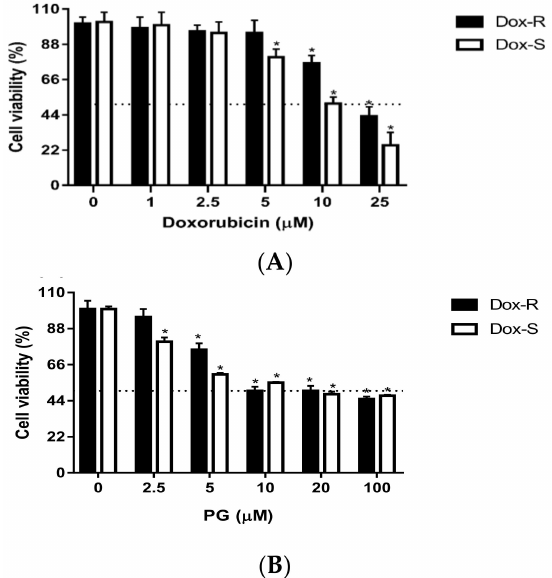
Figure 1. Cytotoxicity of (A) doxorubicin and (B) prodigiosin in A549 and Anti-Dox-A549 cells. A549 (Dox-S) and anti-Dox-A549 cells (Dox-R) were treated with doxorubicin (Dox) and prodigiosin (PG) for 24 h, respectively. Results were represented as mean ± standard deviation (SD) from 3 independent experiments. *, p < 0.05 compared with untreated